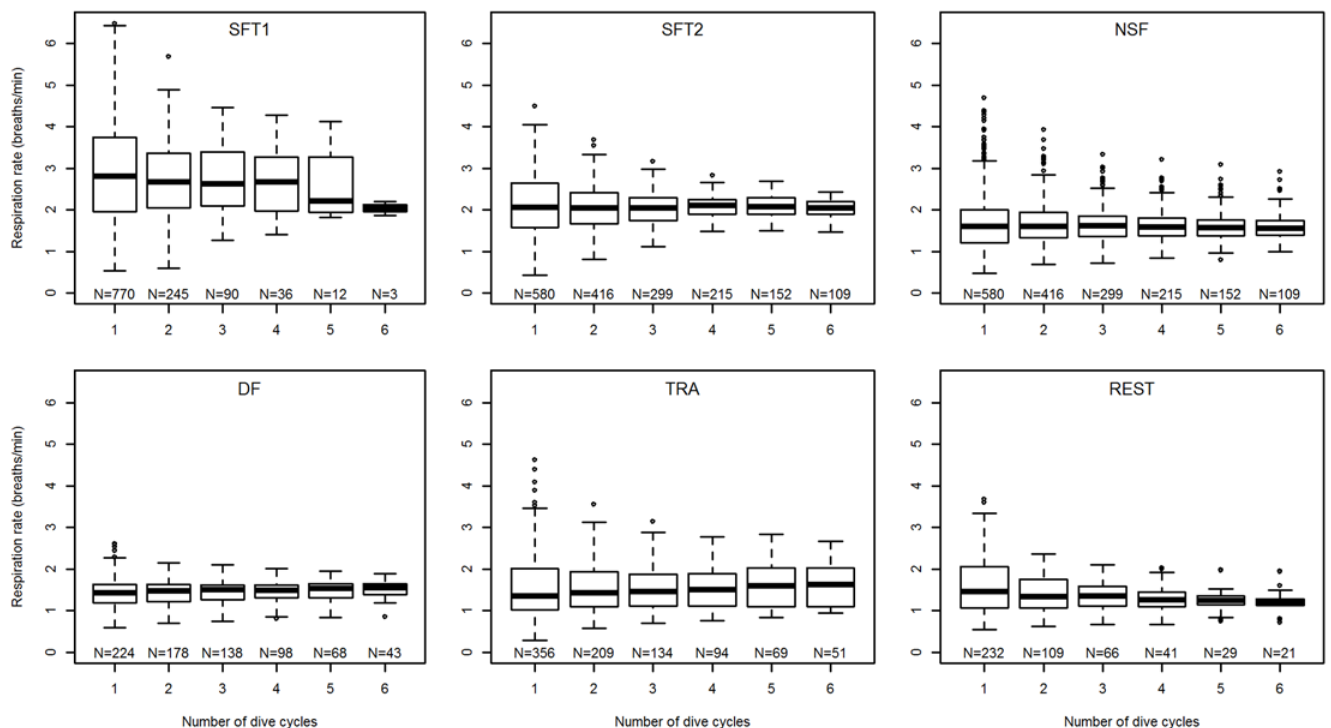
Fig 4. Boxplots of minke whale respiration rates over different temporal scales (dive cycles) for different activity states. SFT1 = surface feeding tactic I, SFT2 = surface feeding tactic II, NSF = near-surface foraging, DF = deep foraging, TRA = traveling, REST = resting.